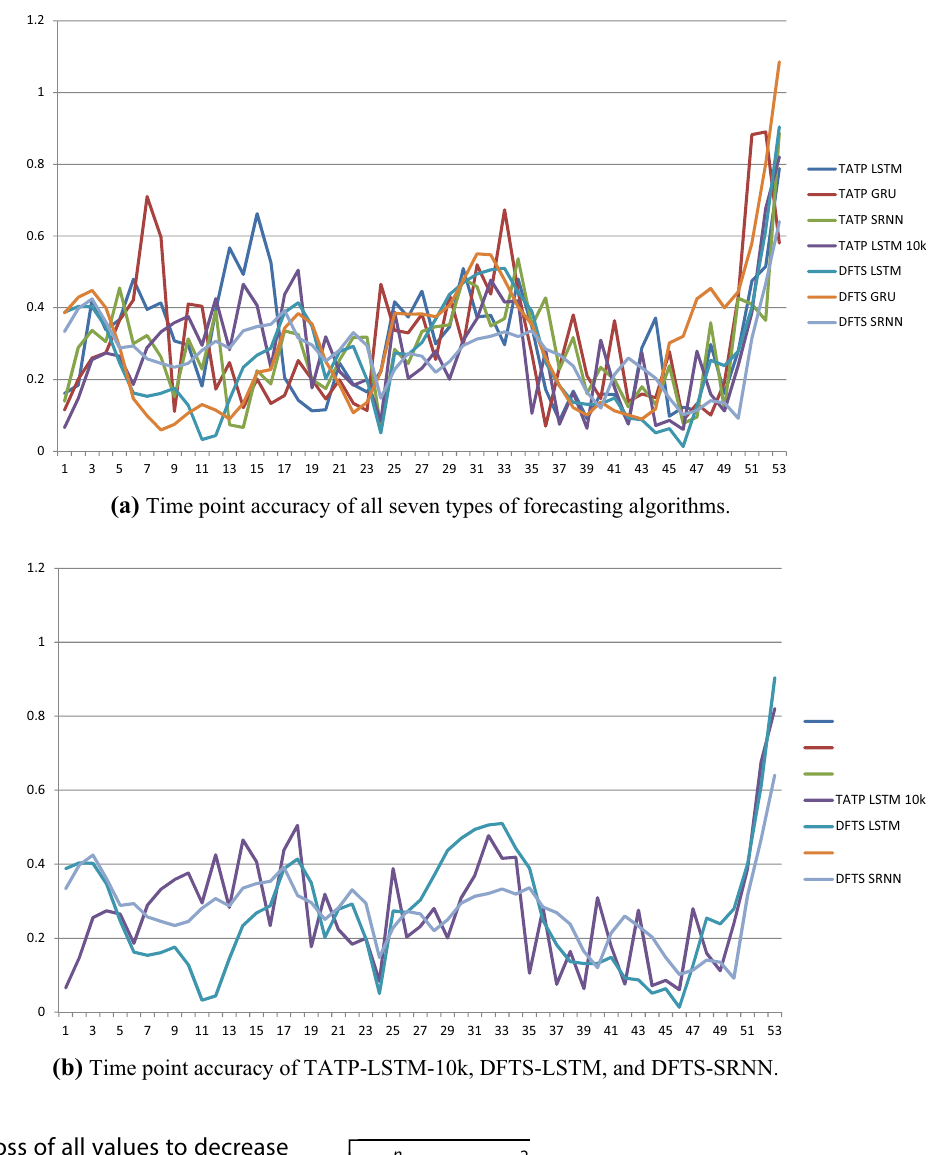
Fig. 4 Time point accuracy of forecasted future time series